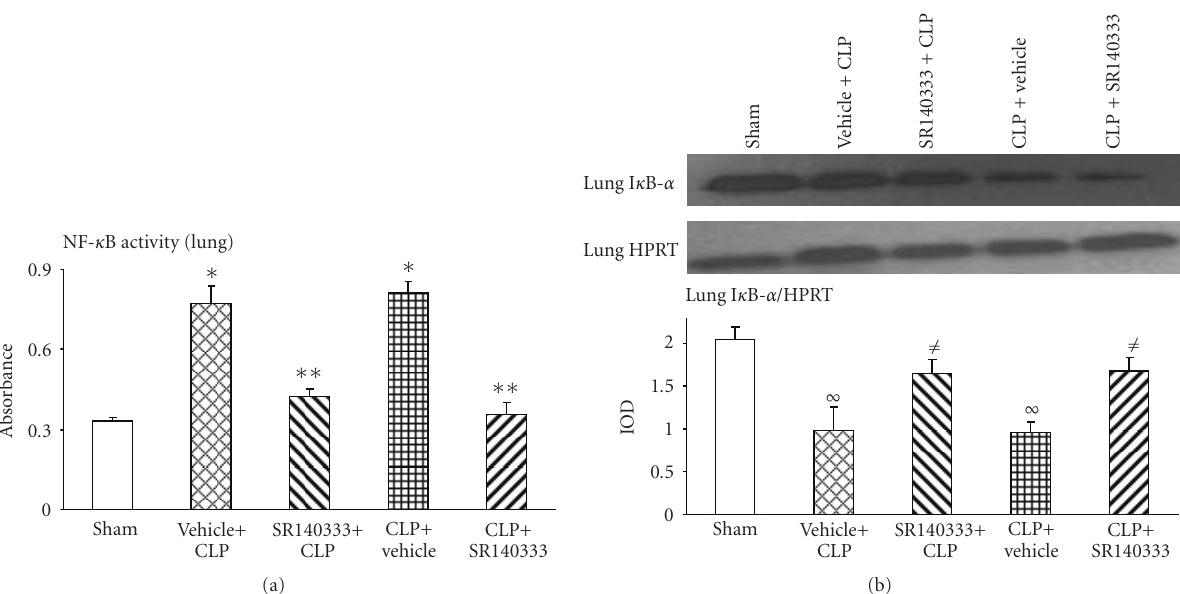
Figure 1: E ff ect of SR140333 administration, either 30 minutes before or 1 hour after CLP, on lung NF- κ B DNA-binding activity. Mice ( n = 6–9 in each group) were divided into CLP-operated and sham-operated groups. CLP-operated mice received vehicle (DMSO in PBS, 0.25% v/v) or SR140333 (1mg/kg; 0.25mg/mL) s.c. either 30 minutes before (pretreatment) or 1 hour after (posttreatment) the CLP. Same surgical procedure as the CLP-operated animals except the cecal ligation and puncture was performed on sham-operated animals. 8 hours after the CLP procedure, mice were sacrificed, and lung (a) NF- κ B DNA-binding activity and (b) I κ B- α level (representative I κ B- α and HPRT control bands shown on the upper panel) were determined. Results shown are the mean ± S.E.M. “Vehicle + CLP” and “SR140333 + CLP” represent the groups that received vehicle and SR140333 treatment, respectively, commencing 30 minutes prior to CLP. “CLP + vehicle” and “CLP + SR140333” represent the groups that received vehicle and SR140333 treatment, respectively, 1 hour after CLP. ∗ P < . 001 when vehicle-treated CLP animals were compared with sham group animals; ∗∗ P < . 001 when SR140333-treated CLP animals were compared with vehicle-treated CLP animals; ∞ P < . 01 when vehicle-treated CLP animals were compared with sham group animals; / = P < . 05 when SR140333-treated CLP animals were compared with vehicle-treated CLP animals. CLP: cecal ligation and puncture; HPRT: Hypoxanthine guanine phosphoribosyl transferase; IOD: integrated optical density.